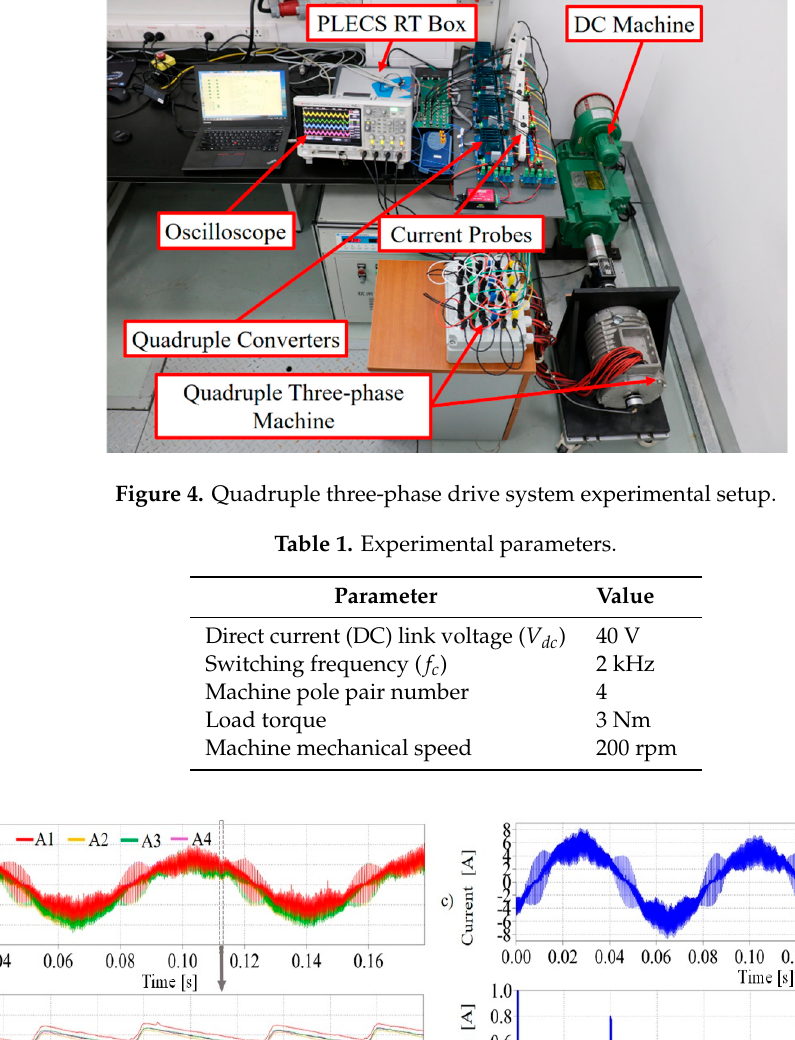
Figure 6. ( a ),( b ) Experimental result of phase currents with phase-shift CPWM. ( a ) Two fundamental period range. ( b ) The cursor range of Figure 6a. ( c ),( d ) Equivalent phase current with phase-shift CPWM. ( c ) Time-domain current waveform. ( d ) FFT spectrum of Figure 6c. Figure 6 describes the experimental results of phase currents applying the proposed phase-shift CPWM. According to the analytical models in Section 3, the carrier phase angles 𝜃 (cid:3030)(cid:2869) = 0 , 𝜃 (cid:3030)(cid:2870) = (cid:3095) (cid:2870) , 𝜃 (cid:3030)(cid:2871) = 𝜋 and 𝜃 (cid:3030)(cid:2872) = (cid:2871)(cid:3095) (cid:2870) are applied to the four subsystems accordingly. Similar to Figure 5, Figure 6a shows the four subsystem phase current waveforms, while Figure 6b presents the cursor range of Figure 6a. According to Figure 6b, it is can be seen that the phase currents in the carrier signal period range are effectively shifted with proposed phase-shifted CPWM, while they are synchronized in Figure 5b. Figure 6c, d show the equivalent phase currents waveform and its FFT spectrum applying the proposed phase-shift CPWM. The current THD of Figure 6a,c are 36.1% and 12.1%, respectively. In terms of Figures 5a and 6a, it can be observed that the phase current THD is slightly increased with phase-shifted CPWM. This is mainly caused by the mutual coupling effect among machine stator windings, and the increase of phase current THD will result in a higher copper loss of the machine. Different machine stator layouts will result in different mutual coupling effect, which is worthwhile for further analysis in the future. However, this work is mainly aimed at the elimination of the equivalent phase currents to reduce the flux linkage harmonics, torque ripple, vibration and noise in the multi three-phase drives. Figure 6c shows that the equivalent current waveforms are significantly smoothed in respect with Figure 5c, and the current THD is reduced from 28.5% in Figure 5c to 12.1% in Figure 6c. Comparing Figure 5d,c, the majority of phase current harmonic components in Figure 6d are eliminated, except the harmonics around 8 kHz and 16 kHz, which are four times and eight times the switching frequency, respectively ( 𝑚 = 1 and 𝑚 = 2 ). This result matches the analytical Equations (16) and (17) in Section 3 and the FFT spectra in Figure 3 (the layer of 𝑁 = 4 ). Therefore, the experimental results have